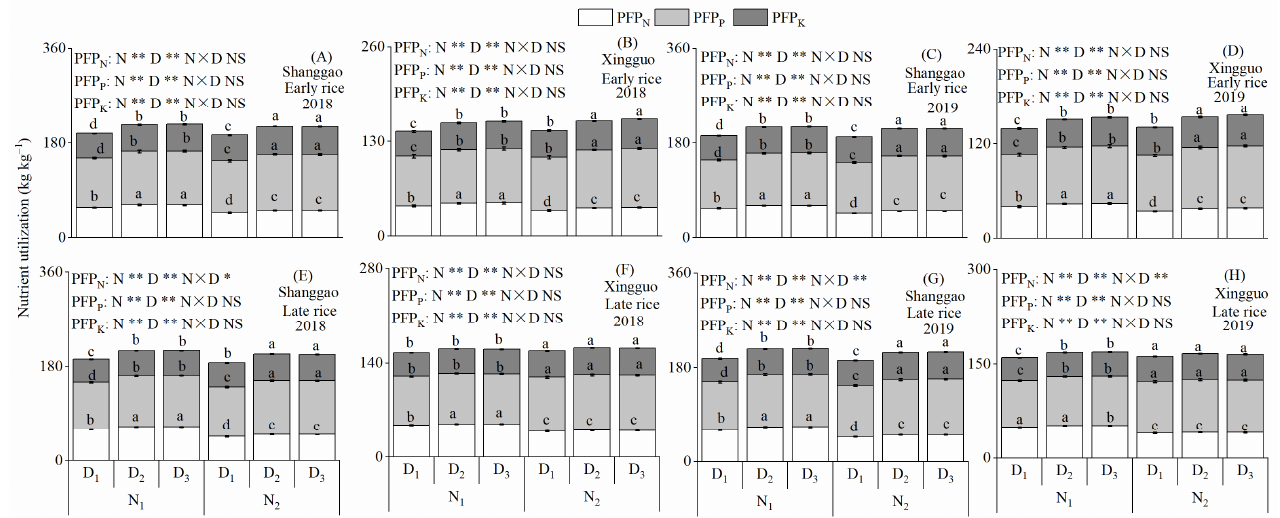
Figure 3. PFP N , PFP P and PFP K of double cropping rice ( A – H ) response to the N rate and plant density in two different ecological regions in 2018 and 2019. N 1 and N 2 represent 120 and 150 kg ha − 1 for early rice and N 1 and N 2 represent 120 and 165 kg ha − 1 for late rice. D 1 , D 2 and D 3 represent 86, 143 and 200 plants per m 2 for early rice and D 1 , D 2 and D 3 represent 57, 114 and 172 plants per m 2 for late rice. Values followed by different lowercase letters are significantly different at the 0.05